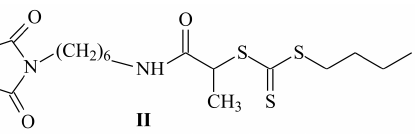
Figure 2. The structure of urazole-functionalized trithiocarbonate ( II ).